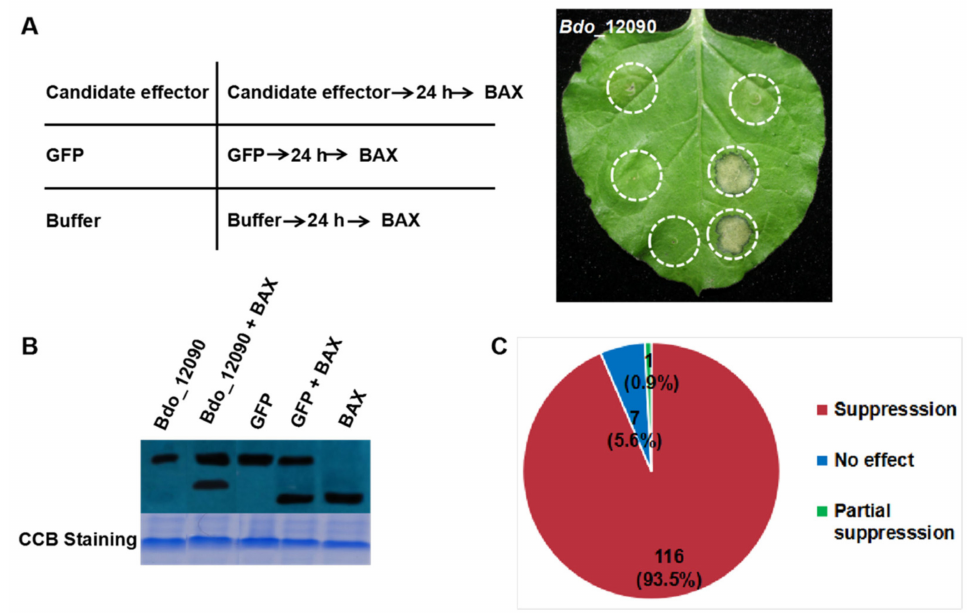
Figure 2. Suppression of BAX-triggered programmed cell death (BT-PCD) in N. benthamiana by candidate effectors in B. dothidea (example Bdo_12090). ( A ) Cell death suppression of Bdo_12090 by Agrobacterium -mediated transient expression in N. benthamiana . N. benthamiana leaves were infiltrated with buffer and Agrobacterium cells carrying Bdo_12090 or the GFP gene; infiltration was either performed alone or followed 24 h later by infiltration with Agrobacterium cells carrying a mouse Bax gene. The Representative photo was acquired 5 d after the last infiltration. Positions of Candidate effector, GFP, and Buffer in the left table correspond to the infiltration sites on the right leaf photograph, respectively. ( B ) Western blotting was used to confirm the expression of Bdo_12090, GFP and BAX in ( A ), and equal loading is indicated by coomassie blue (CBB) staining. ( C ) The number of candidate effectors and their proportion that showed suppression or no effect of BT-PCD on leaves of N. benthamiana .